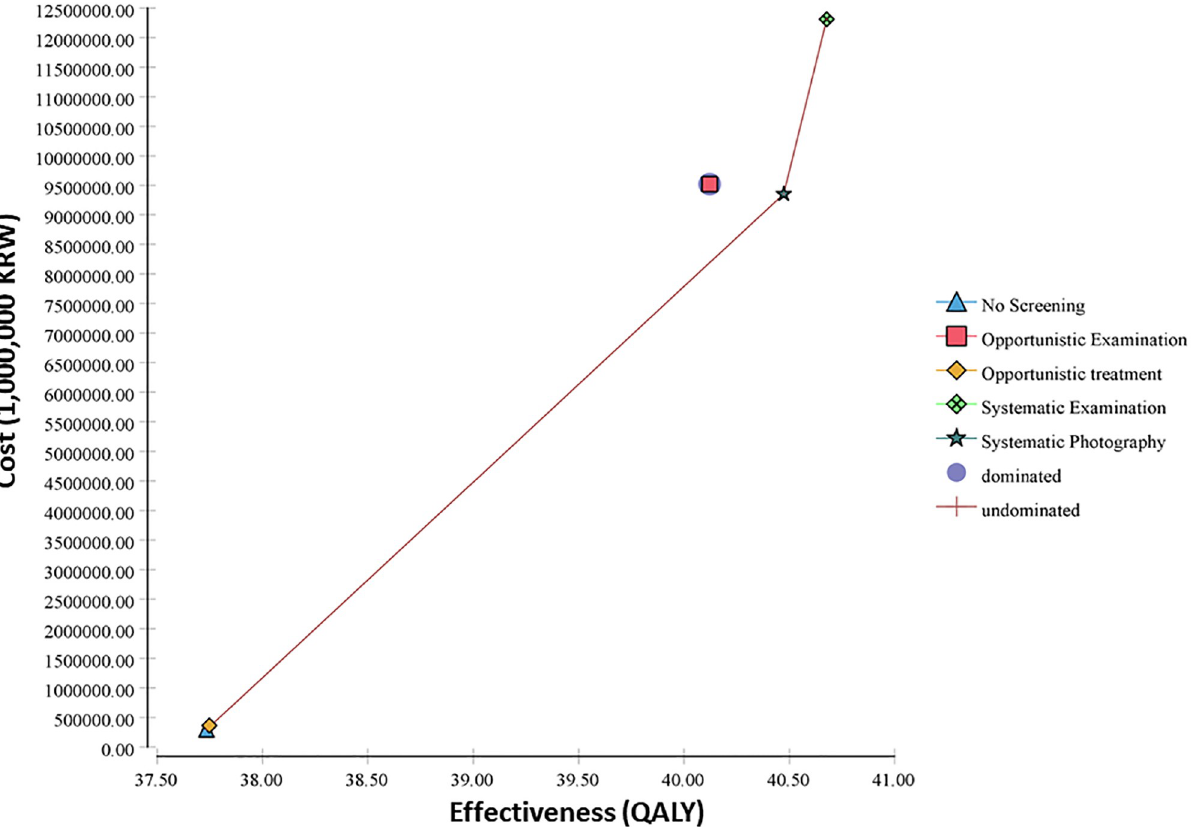
Fig 1. Cost-effectiveness plane comparing the effectiveness of status quo (no screening) and the four screening strategies (opportunistic examination, systematic examination, systematic photography, and opportunistic treatment).